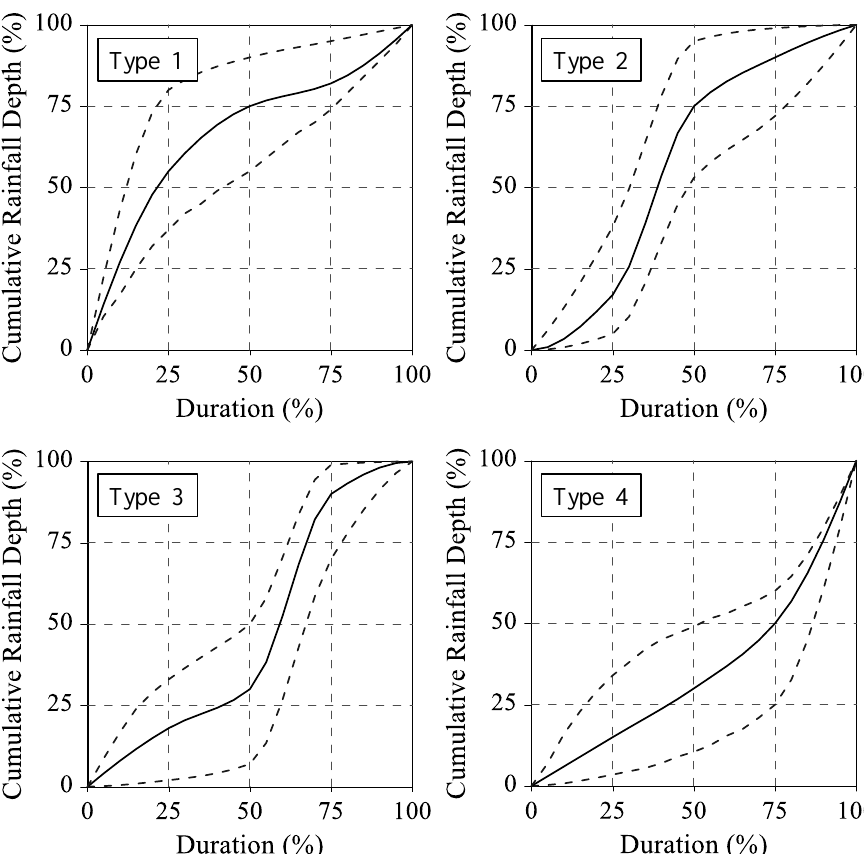
Figure 2. Huff’s four rainfall types with the corresponding median (solid line) and 10% and 90% cumulative probabilities (lower and upper dashed lines, respectively).